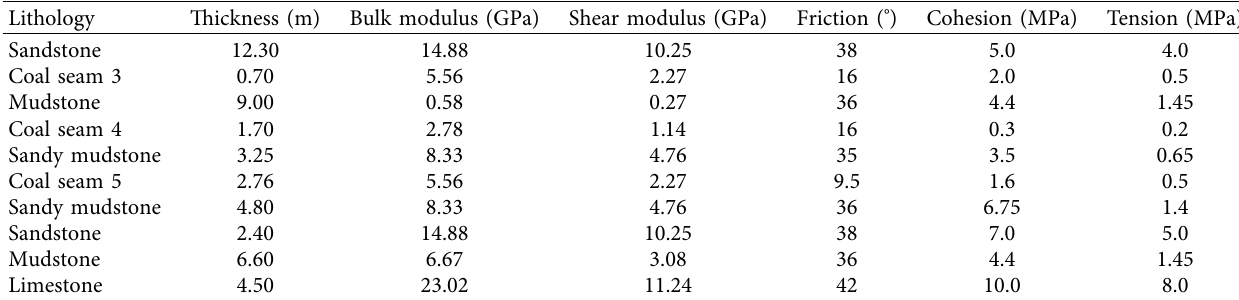
Table 1: Geological and engineering conditions of the research object.